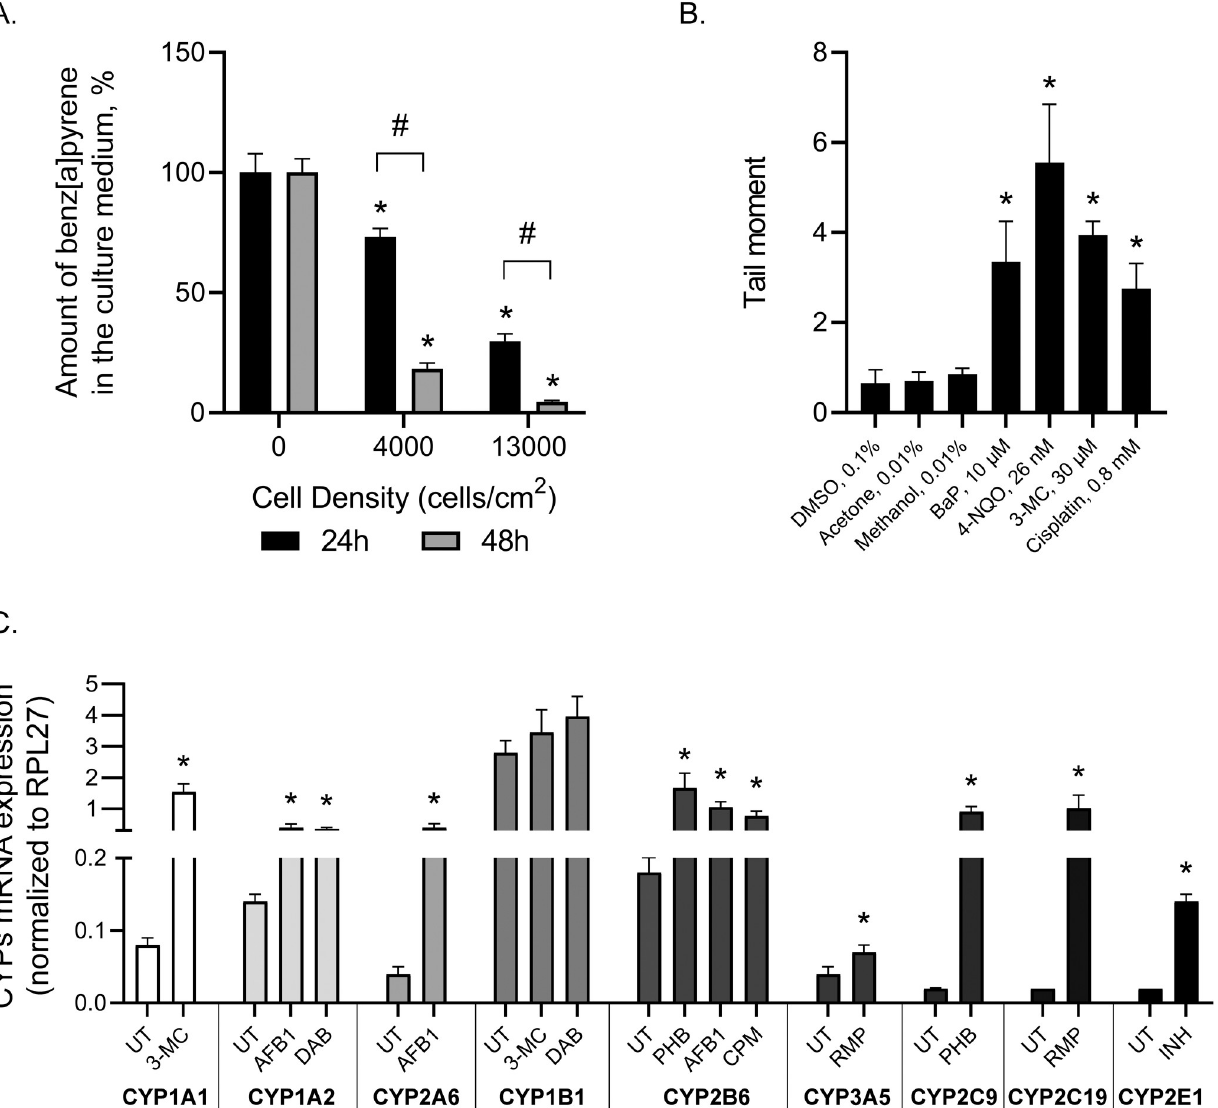
Fig 5. Metabolic competence of HeLa TI cells. A. Metabolism of procarcinogen benzo[a]pyrene by HeLa TI cells; Shpol’skii method. B. Level of DNA damage in HeLa TI cells after carcinogen and procarcinogen treatment; Comet assay. C. Activity of different CYP450 isoform genes in HeLa TI cells after treatment with microsomal oxygenase inductors, qRT-PCR (results are presented as the fold change (2 − Δ CT) in the level of the expression, which was normalized to that of the RPL27 gene). The values are expressed as the means ± SD, and “ � ” indicates the level of significance (p < 0.05).